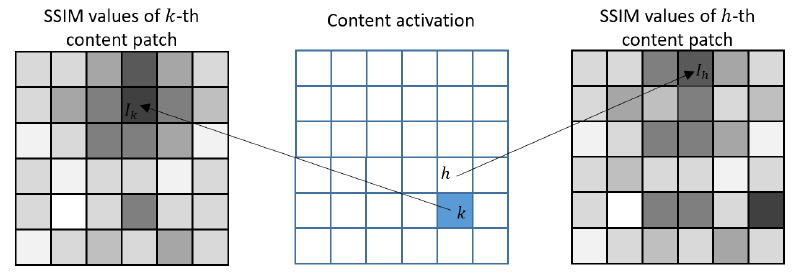
Figure 2. The spatial continuity of style patches in content